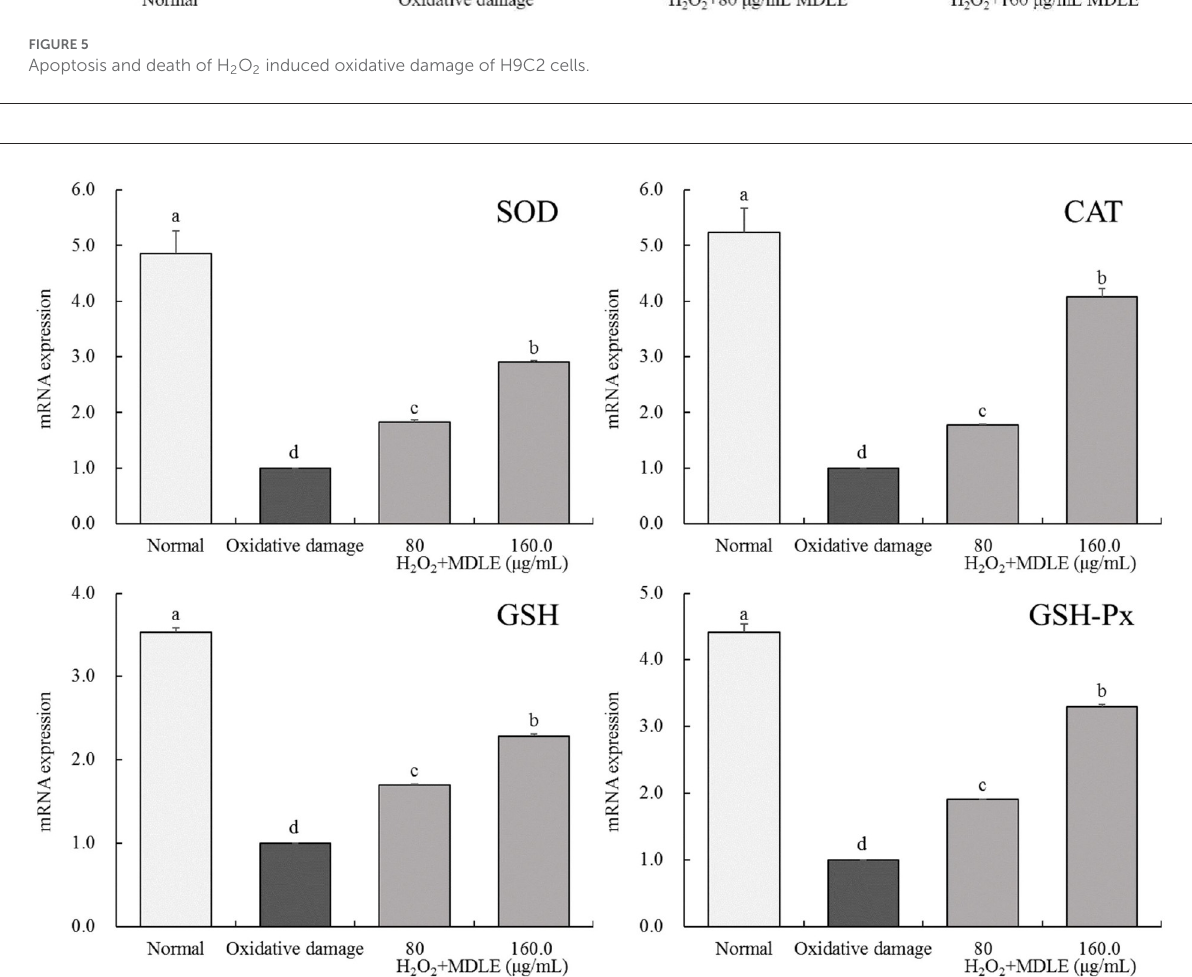
FIGURE6 SOD , CAT , GSH , and GSH-Px mRNA expression of Malus doumeri leaf extract (MDLE) treatment on H 2 O 2 induced oxidative damage of H9C2 cells. a − d Lowercase letters are used to indicate significant differences at the P < 0.05 level. The same letter group indicates no difference, and the letter difference group indicates difference.